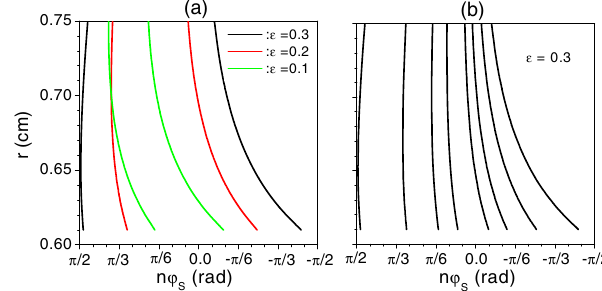
FIG. 2. Phase grouping of the charge drifting towards the magnetron anode in the considered magnetron model. Graph (a) shows the phase boundaries of trajectories of the charges contributing to the synchronous wave in dependence on ε . Graph (b) shows trajectories of the charges in a spoke at ε ¼ 0 . 3